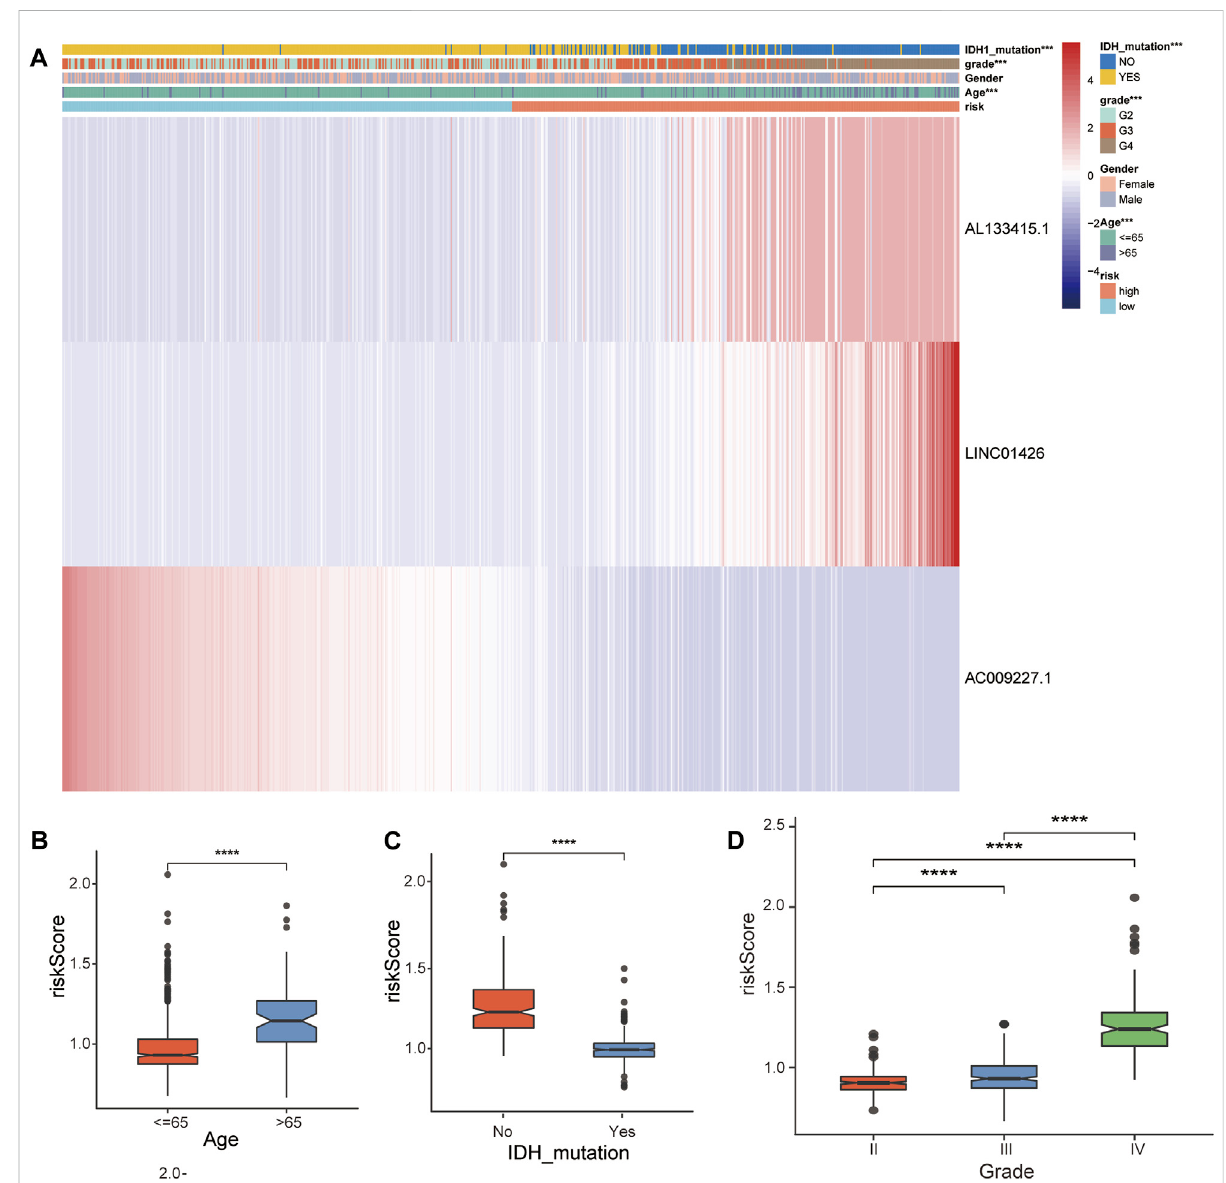
FIGURE 5 Correlation analysis between the prognostic FRLS and clinicopathological characteristics in the TCGA cohort. (A) Heatmaps depict the distribution of FRLS expression levels and clinicopathological features in high-risk and low-risk groups. (B – D) Different risk score levels in